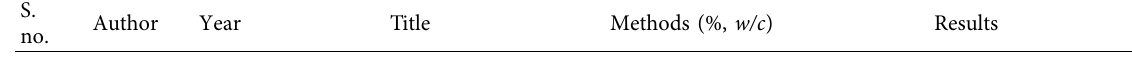
Table 14: Summary of the results of the effects on concrete and